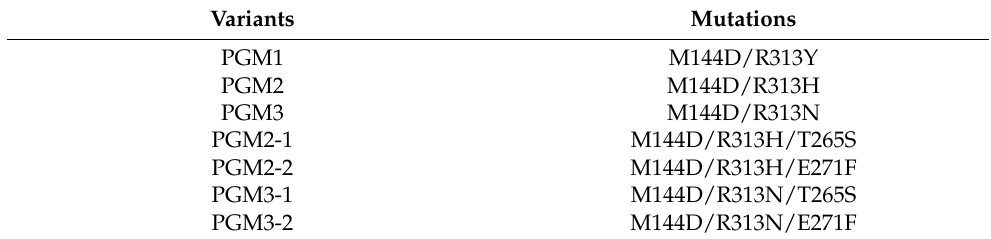
Table 2. All variants and their corresponding mutations in the current